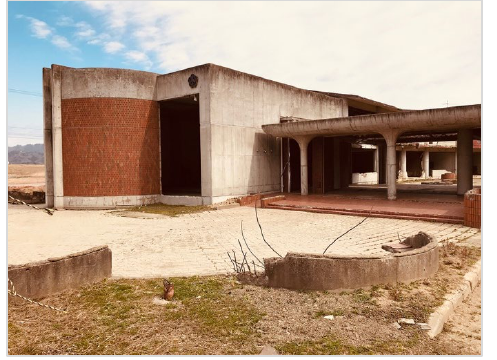
Figure 9 View from the Sight Hill Residential Flat in Glasgow. (Photo by Chris